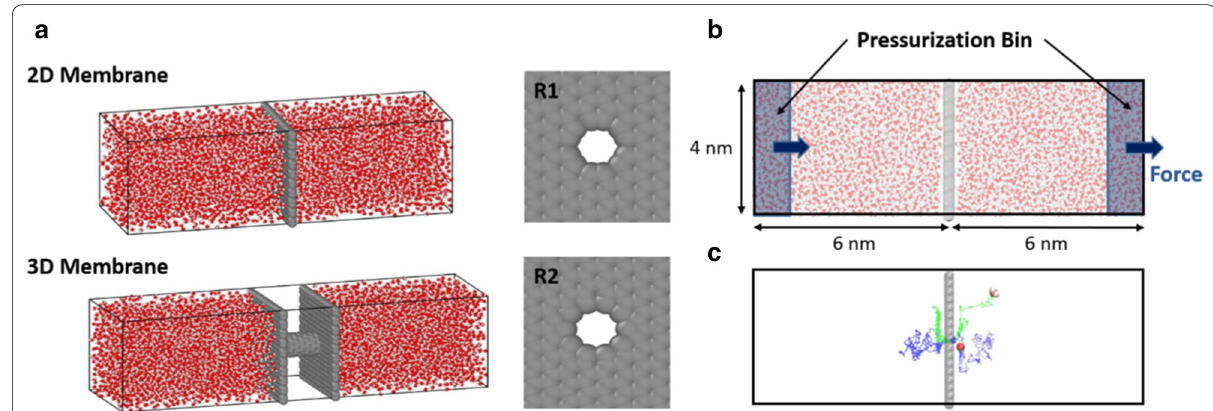
Fig. 1 a Simulation cells with 2D and 3D membrane structure. R1 shows a pore entrance configuration of the 3D membrane. For the 2D membrane structure, both the R1 and R2 entrance configuration were used. The black box lines represent the periodic boundary of the simulation cells. b Application of forces on water molecules during pressure-driven water flow simulations. c Representative trajectory paths of water molecules permeating through the 2D